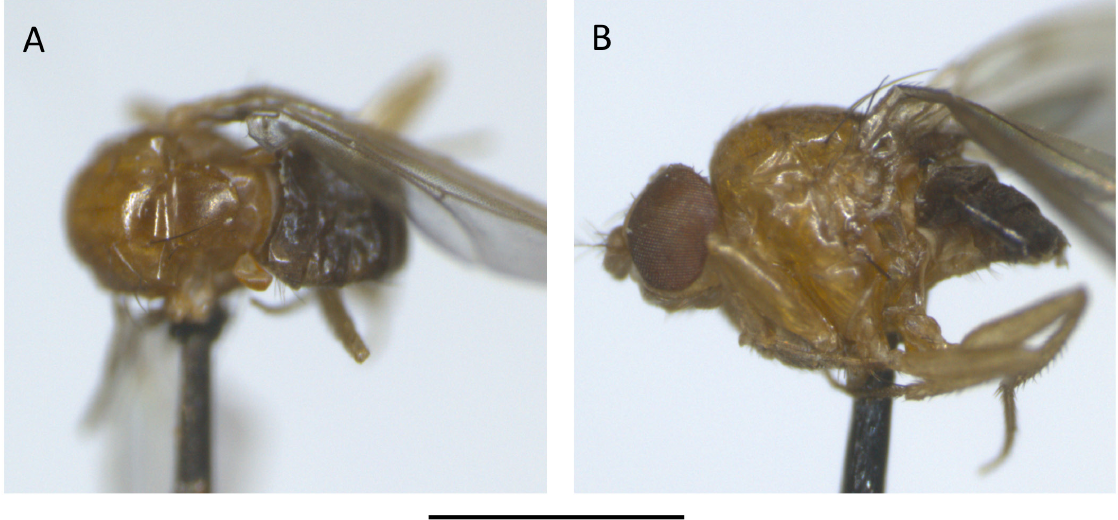
Fig. 7. Photomicrographs of D. ifestia Tsacas, 1984. A . Holotype (P. Vanschuytbroeck and J. Kelenbosch leg.; MNHN). B . Paratype (P. Vanschuytbroeck and J. Kelenbosch leg.; MNHN). Scale bar = 1